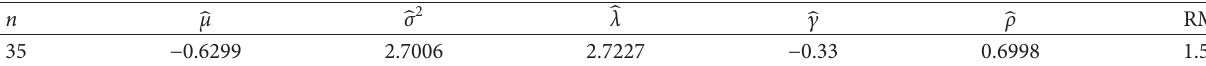
Table 7: The ML estimates and the RMSE value for ARW data with AR(1) innovations.